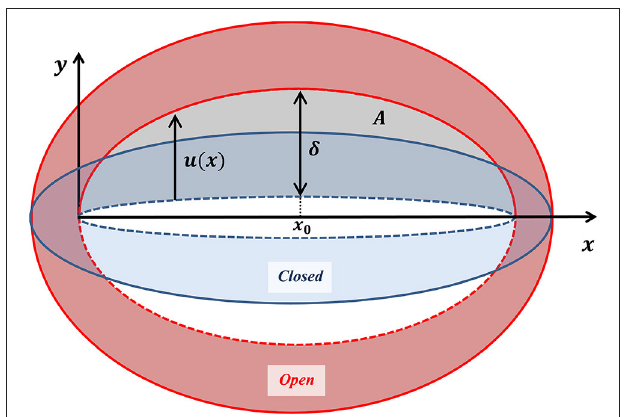
FIGURE 7 | FE results for the stomatal aperture, δ , vs. the opening area, A (black dots), as obtained by increasing ˆ P (for ˆ E results of a simplified parabolic opening displacement (blue dashed-line). Note the linear relation between A and δ , which was obtained for all ˆ E -values